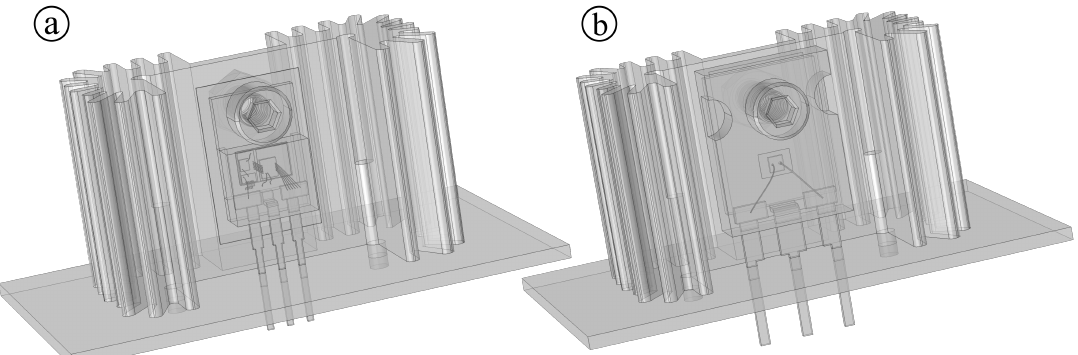
Figure 8. 3D CAD model of ( a ) the cascode GaN MOSFET and ( b ) the SiC MOSFET mounted on a PCB with the RA-T2X-25E heat sink.